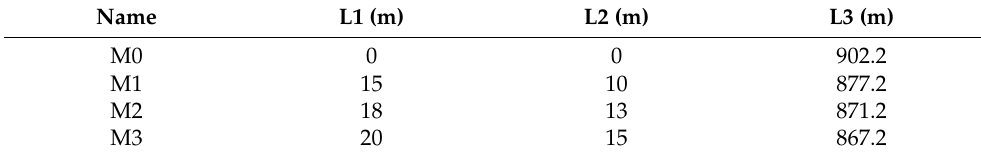
Figure 5. Schematics of original and developed mooring systems: ( a ) original mooring system; ( b ) developed mooring system; ( c ) top view of Spar-type platform with developed mooring system. Table 3. Different developed mooring system configurations for